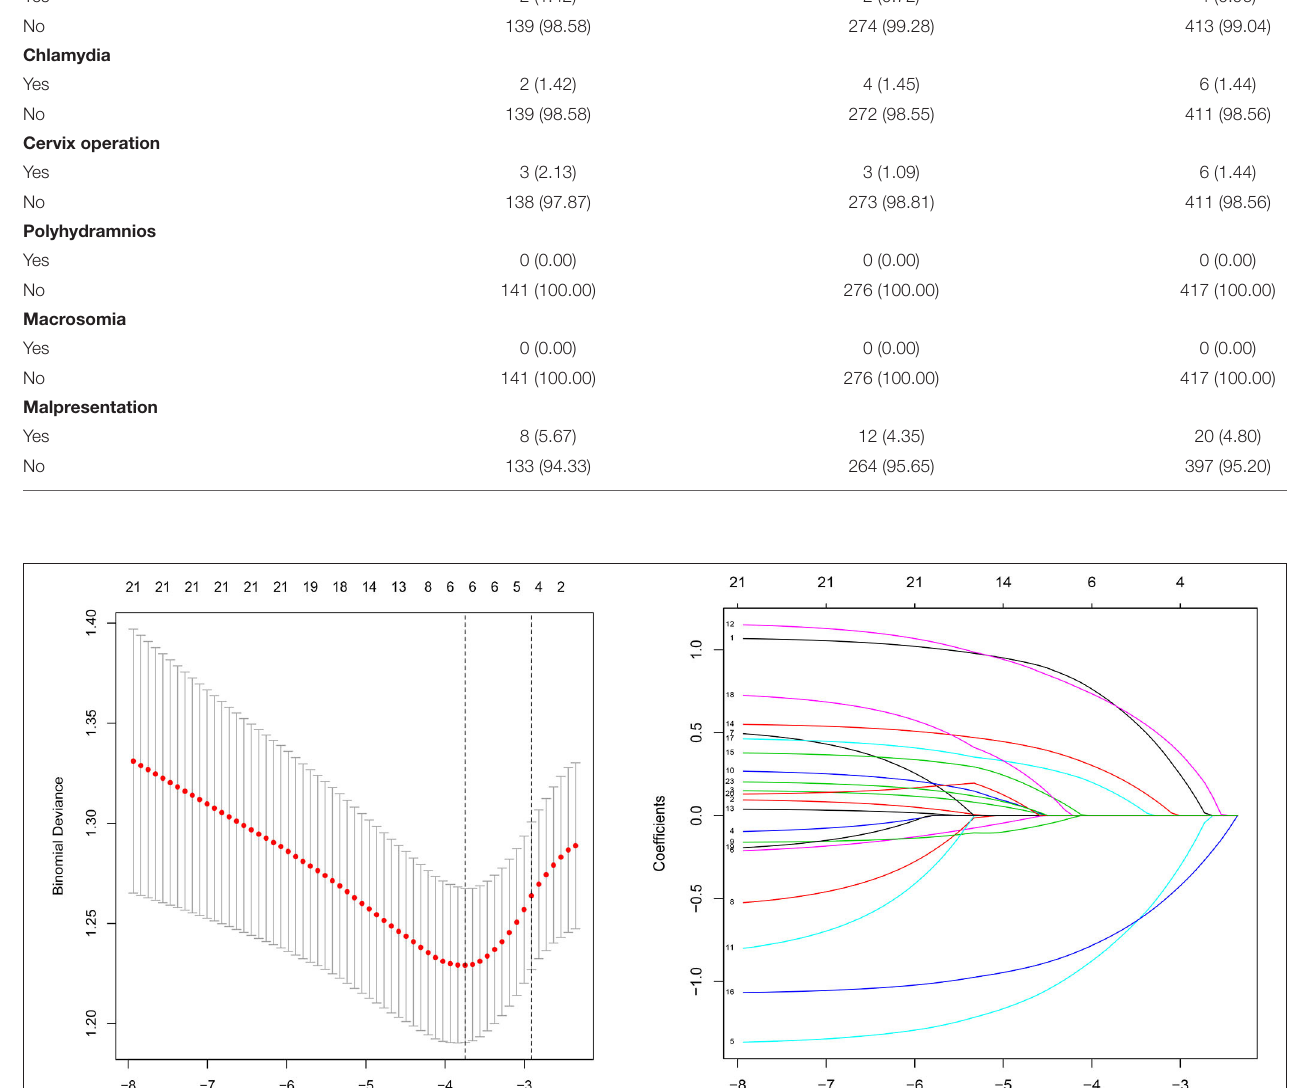
Frontiers in Medicine |